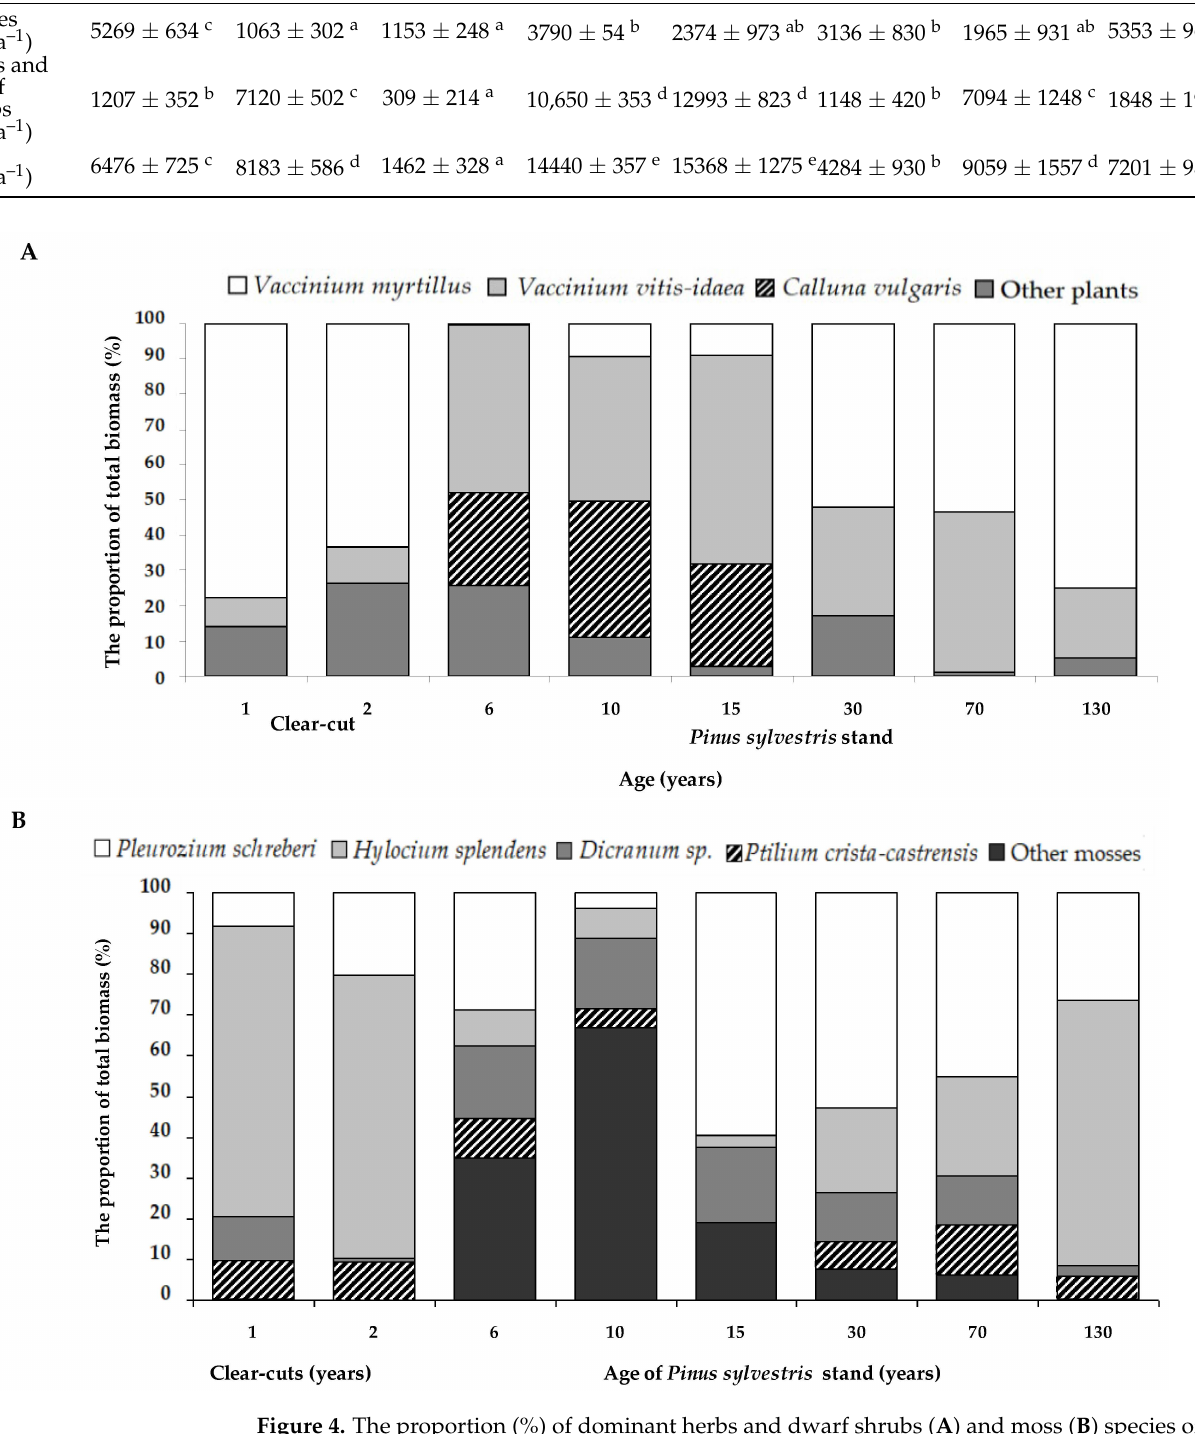
Figure 4. The proportion (%) of dominant herbs and dwarf shrubs ( A ) and moss ( B ) species of the total biomass of dominated ground vegetation species at different Pinus sylvestris sites, including 1–2-year-old clear-cuts and 6–130 years old